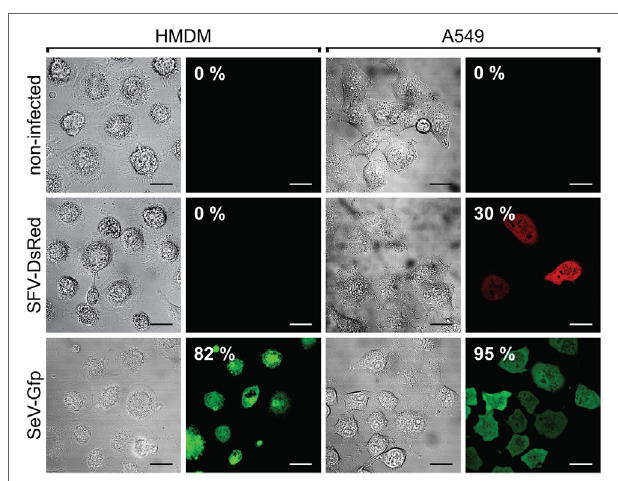
FigUre 3 | Human macrophages are resistant to Semliki Forest virus (SFV) infection. Human monocyte-derived macrophages (HMDMs), and the human lung carcinoma cell line A549 were infected with either SFV-DsRed or SeV-Gfp virus particles. The resulting cell monolayers were analyzed using phase-contrast microscopy, and the expression of DsRed and GFP was evaluated using fluorescence microscopy 24 h